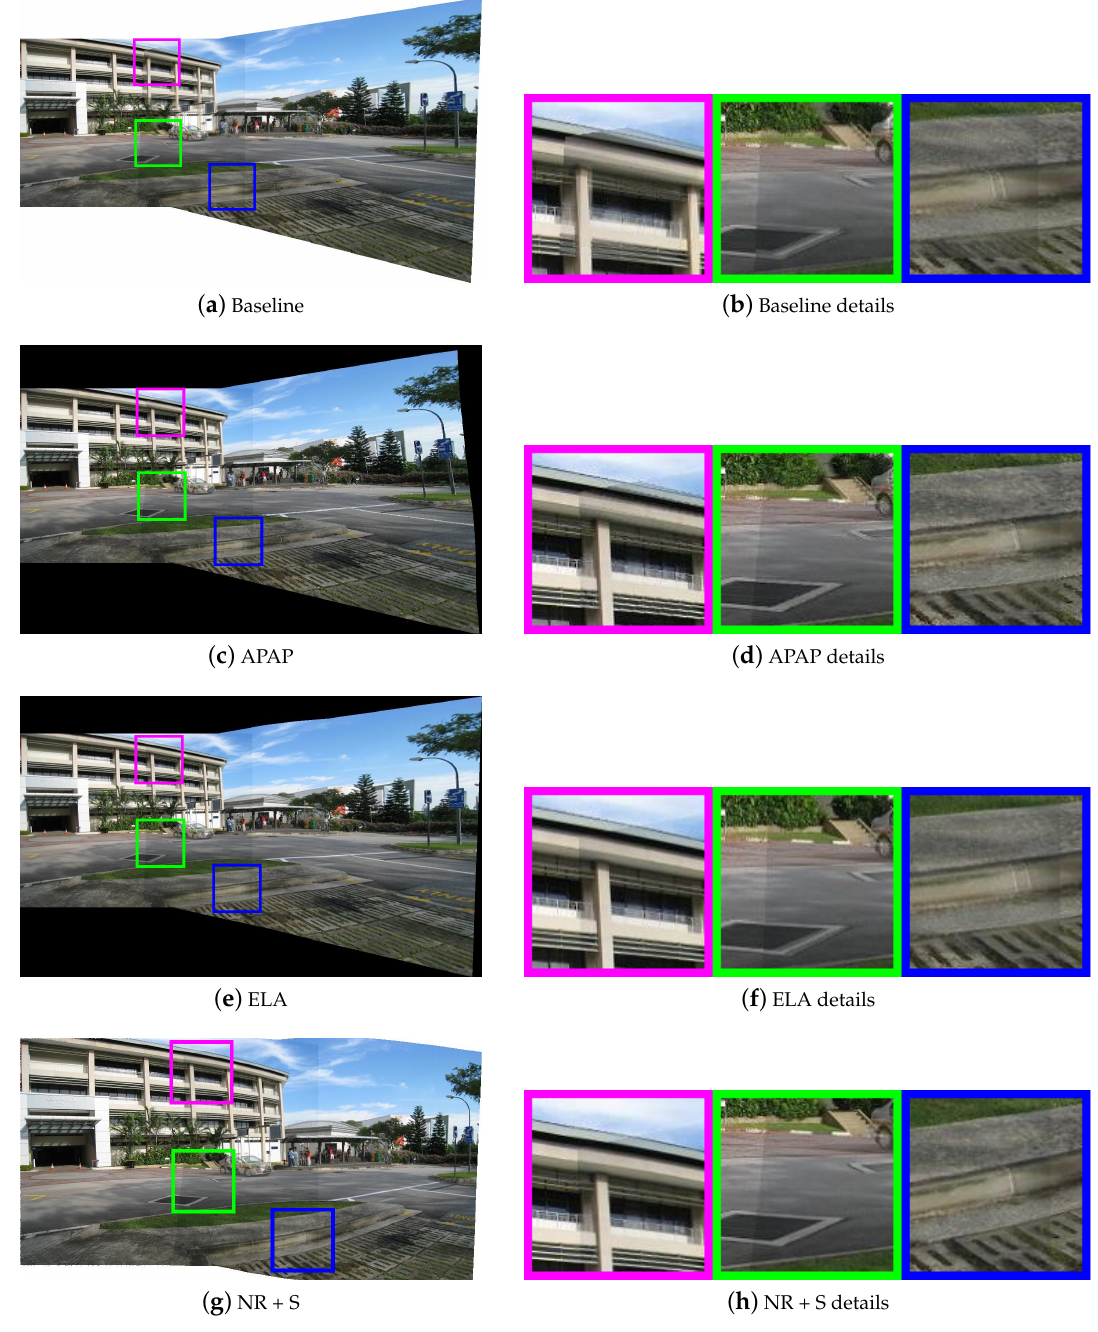
Figure 8. Comparison of stitching quality on “carpark”. ( a , b ) are results of the baseline with obvious local misalignments. ( c , d ) are results of APAP. ( e , f ) are results of ELA. ( g , h ) are results of nonrigid + similarity